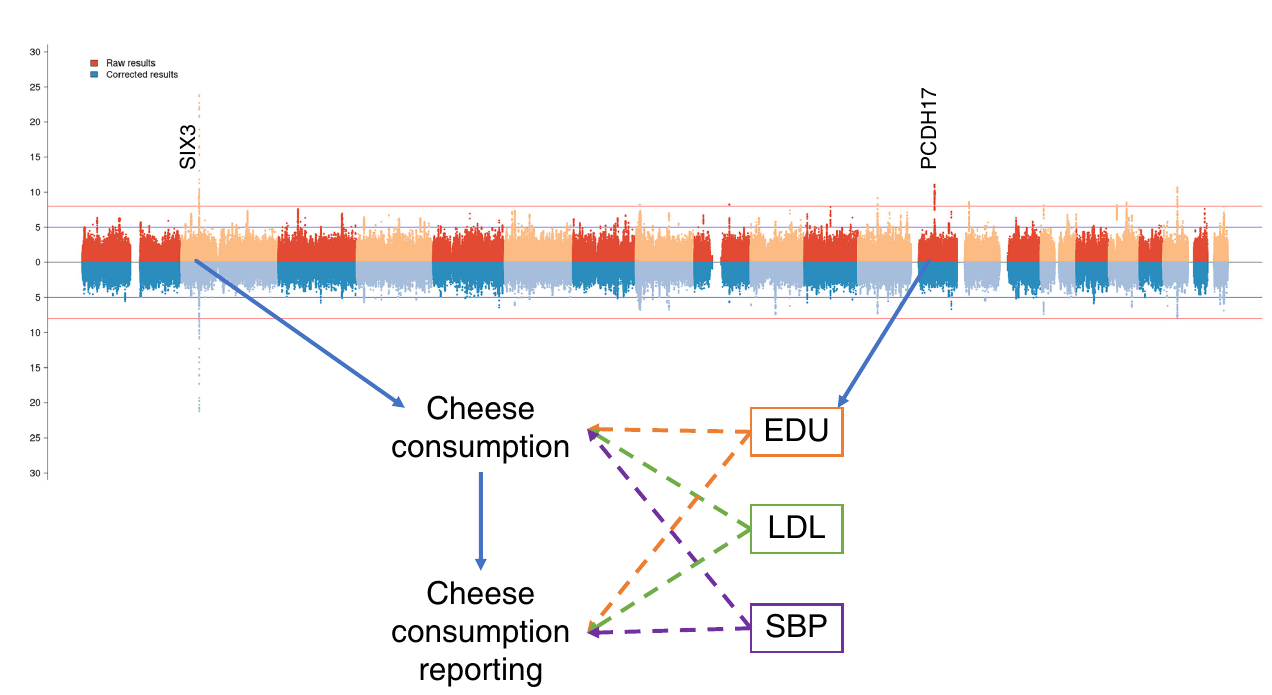
Fig 2. Direct and indirect SNP effects. The plot shows the causal path of exemplar genes identified for cheese consumption. In the multivariable MR model cheese consumption is causally influenced by educational attainment (EDU), low density lipoprotein cholesterol levels (LDL) and systolic blood pressure (SBP). The effect of PDCH17 and is mediated through educational attainment, while SIX3 has a direct effect on cheese consumption. The mediated effects cannot be used reliably as MR instruments as they could be affecting either consumption or its reporting. Moreover, they could act as confounders in the MR analysis and thus they need to be